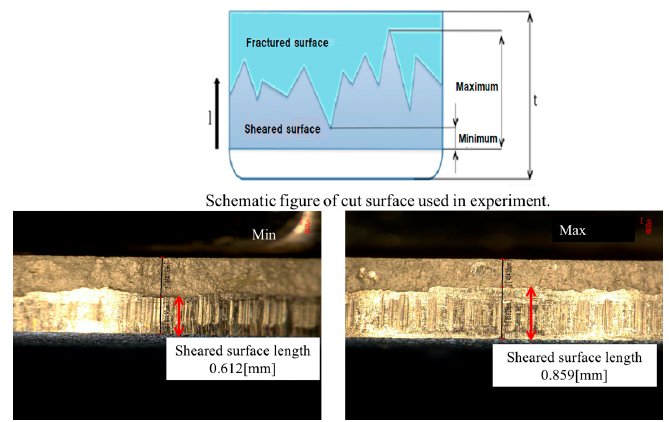
Figure 3. Schematic figure of cut surface used in the experiment, figures of the minimum sheared surface length, and the maximum sheared surface length obtained from the punching experiment.